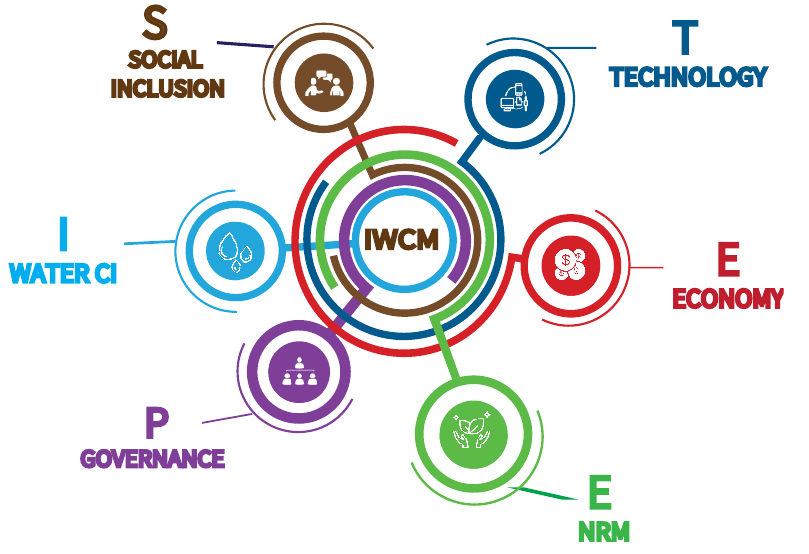
Figure 2. Six categories of STEEPI framework.